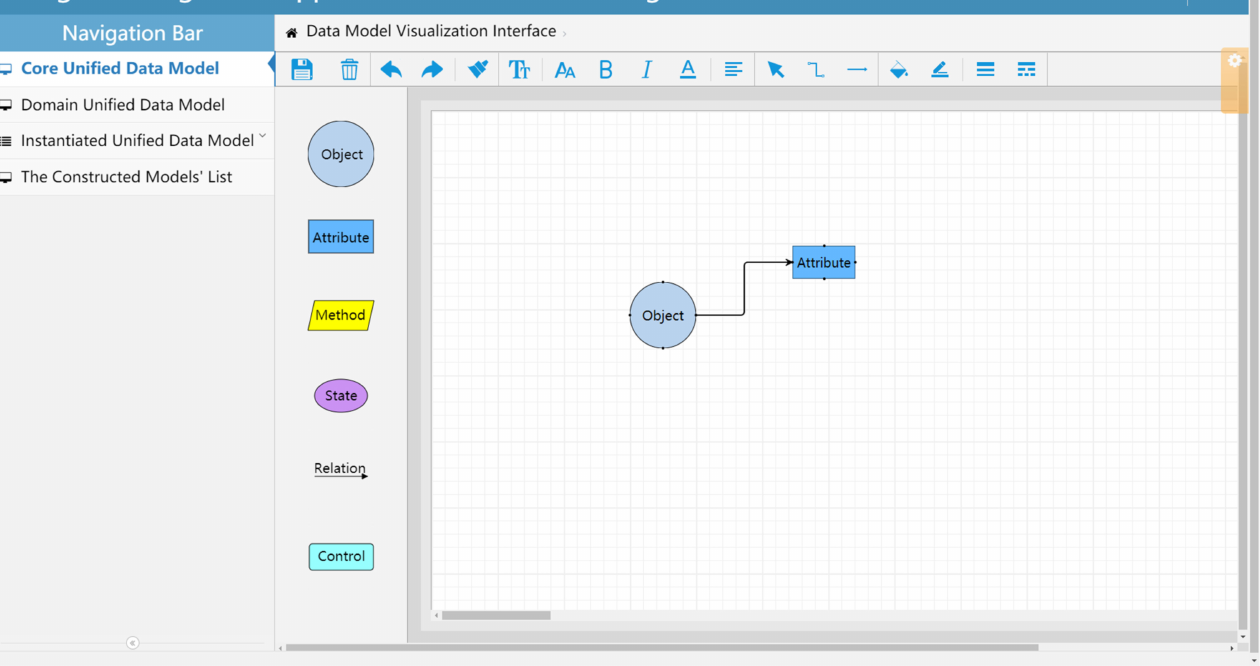
Figure 13. Core unified data model construction.